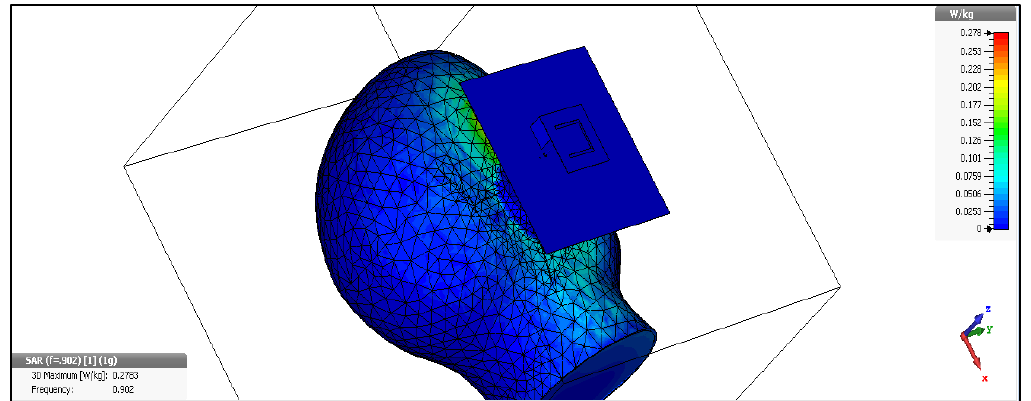
Figure 22. Power distribution before without SRRs